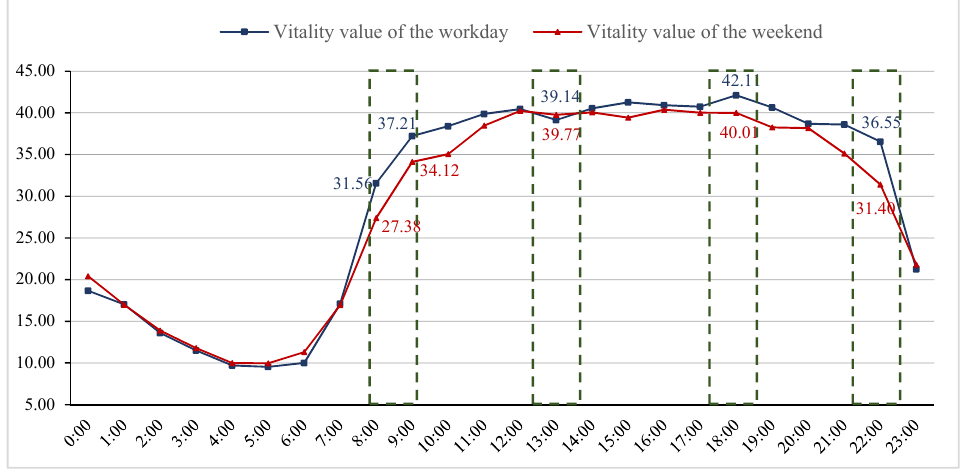
Figure 4. Characteristics of the Temporal Distribution of Spatial Vitality.